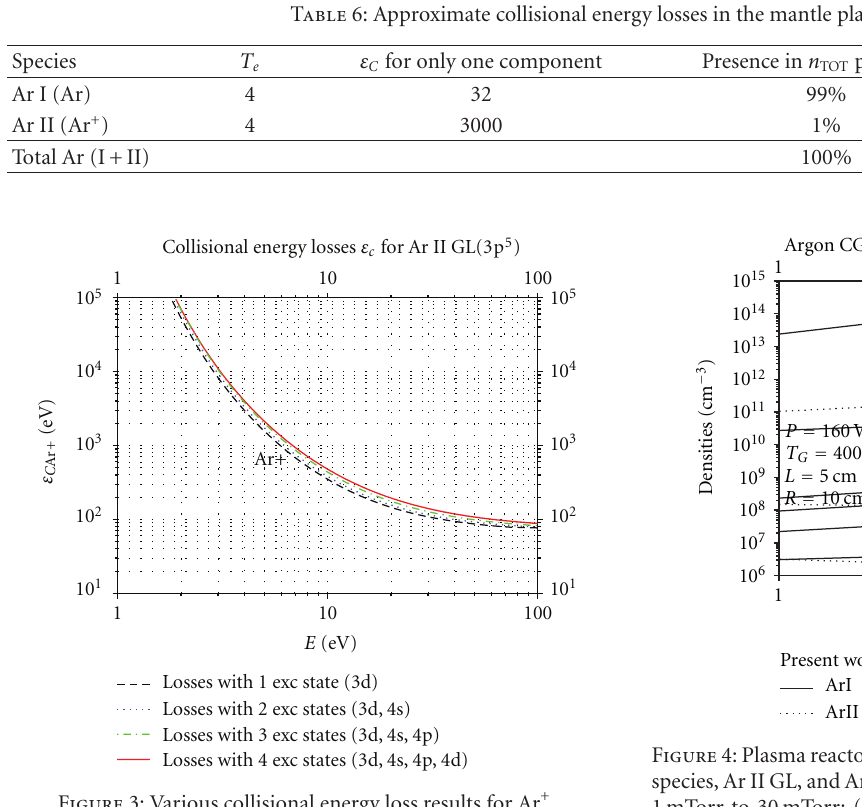
Figure 3: Various collisional energy loss results for Ar + .